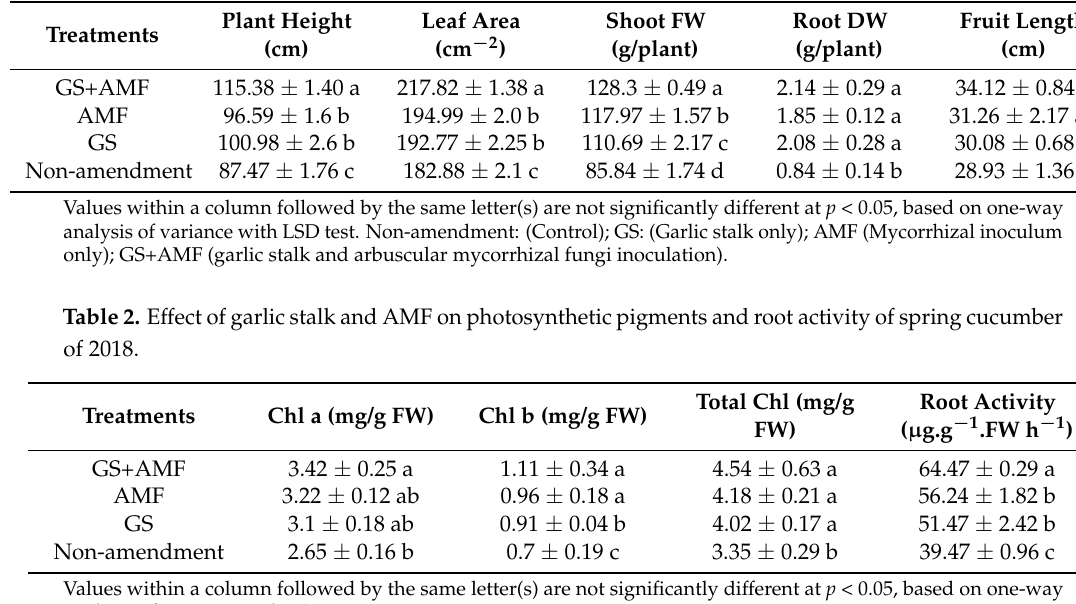
Table 1. The plant growth attributes of greenhouse cucumber under various treatments examined during the spring cultivation of 2018.